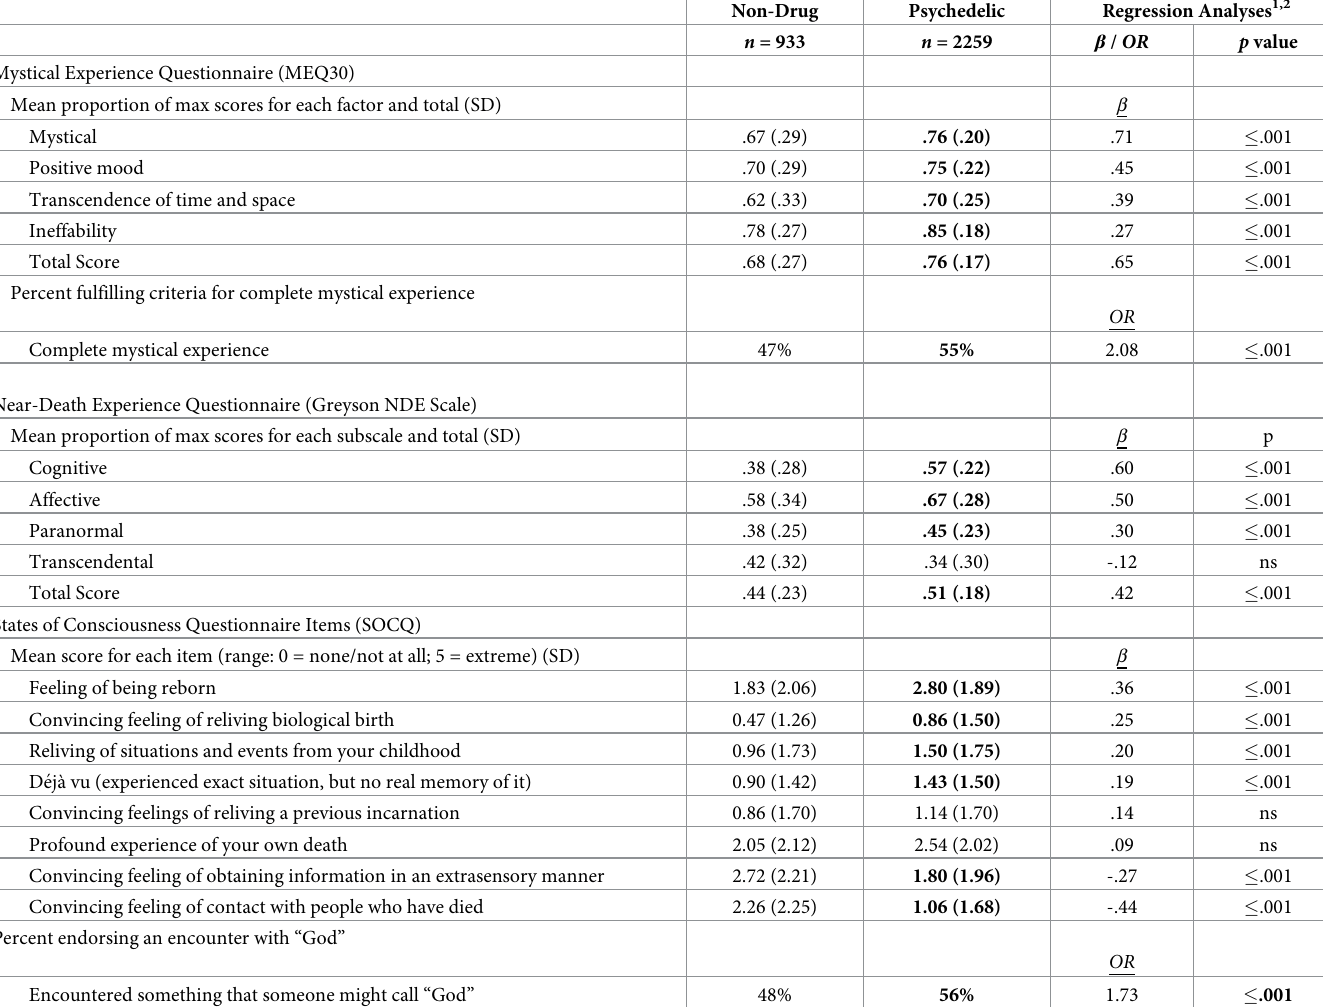
Table 5. Mystical-type and other subjective features of the experience among the Psychedelic Group and the Non-Drug